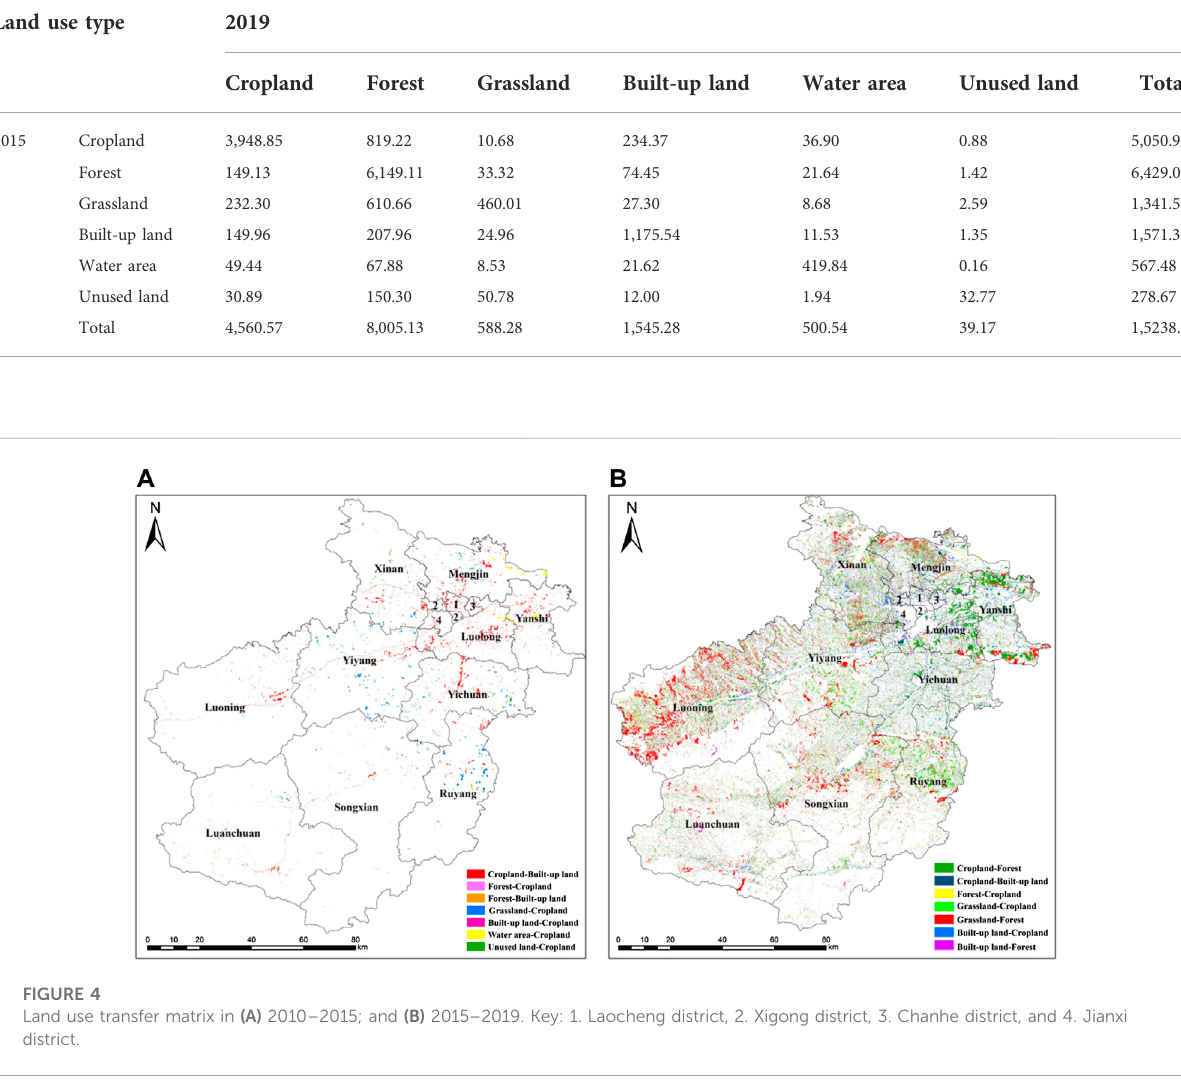
TABLE 4 2015 – 2019 Land Use Transfer Matrix (values in square